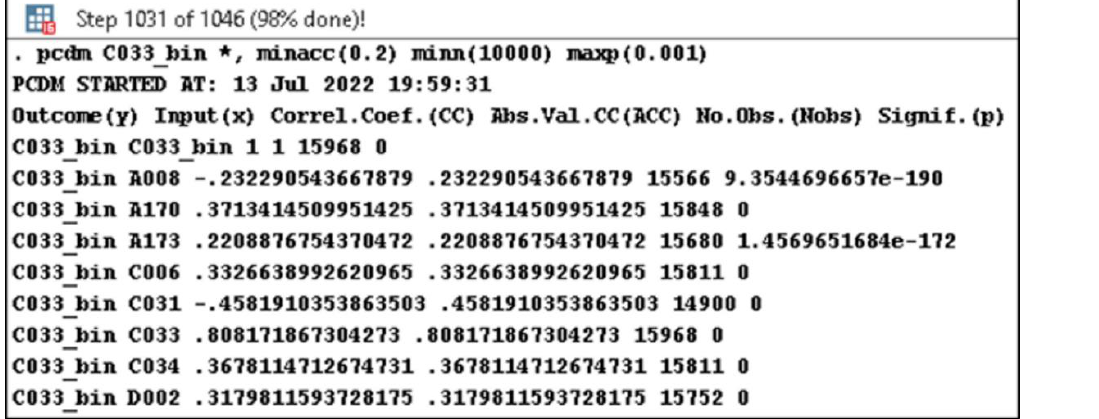
Figure 6. Similar intersecting results using PCDM on a single logical processing core for both forms of the outcome and all three optional arguments for specifying the minimum/maximum limits. Notes: The same as in Figure 2.